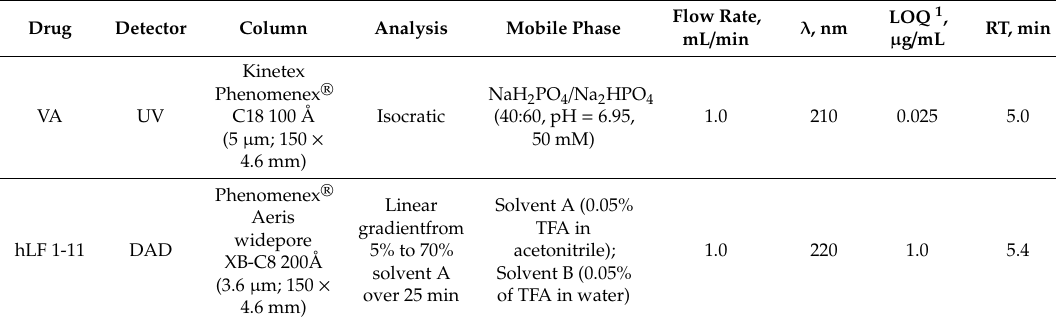
Table 2. Analytical methods specifications.